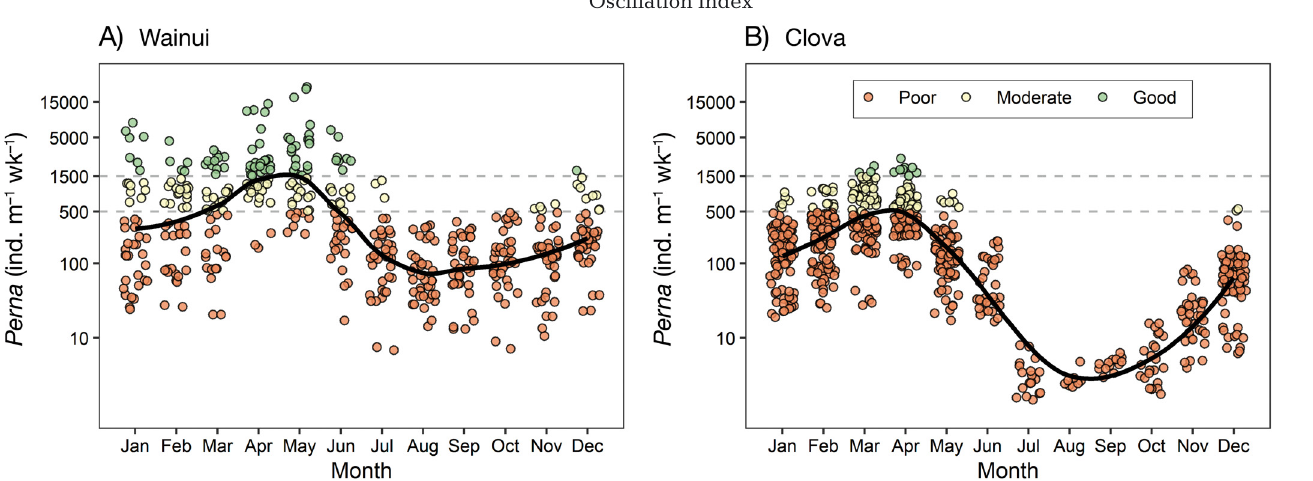
Fig. 7. Monthly model predictions of green-lipped mussel Perna canaliculus spat abundance (ind. m −1 of rope) based on the 25 yr time series data and accounting for the effects of modelled environmental variables. A loess smoother (black line) was added to aid visual interpretation. Abundances are shown in relation to industry categorical scales for spat catching perform- ance (dashed lines) (Poor: 0−500; Moderate: 500−1500; Good: >1500 ind. m −1 wk −1 ) for each of 2 key industry spat-catching sites: (A) Wainui Bay and (B)